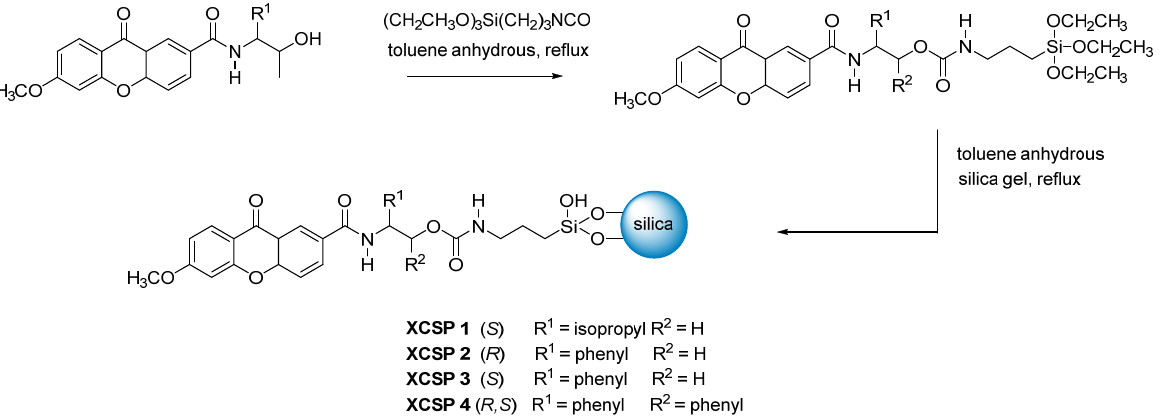
Scheme 1. Synthesis of immobilized-chiral stationary phases based on chiral derivatives of xanthones (XCSPs) using an isocyanate derivative.